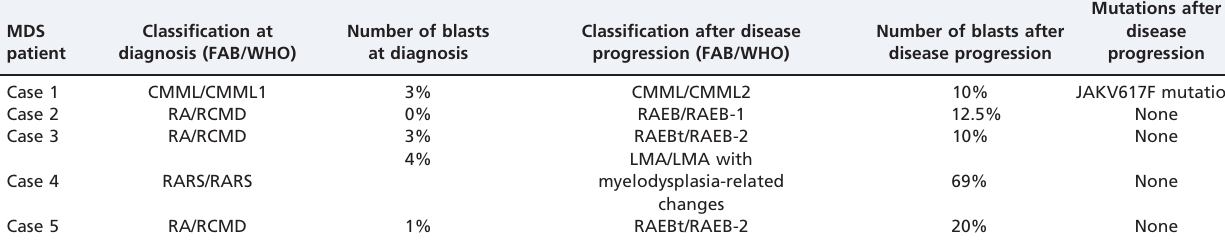
Table 2 - Patient characteristics at diagnosis and after disease